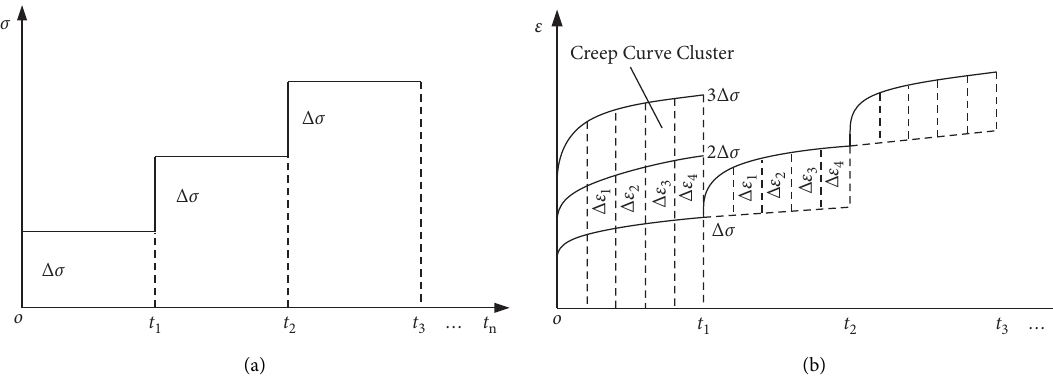
Figure 4: Processing methods for creep curves: (a) the diagram of loading process; (b) deformation diagram.